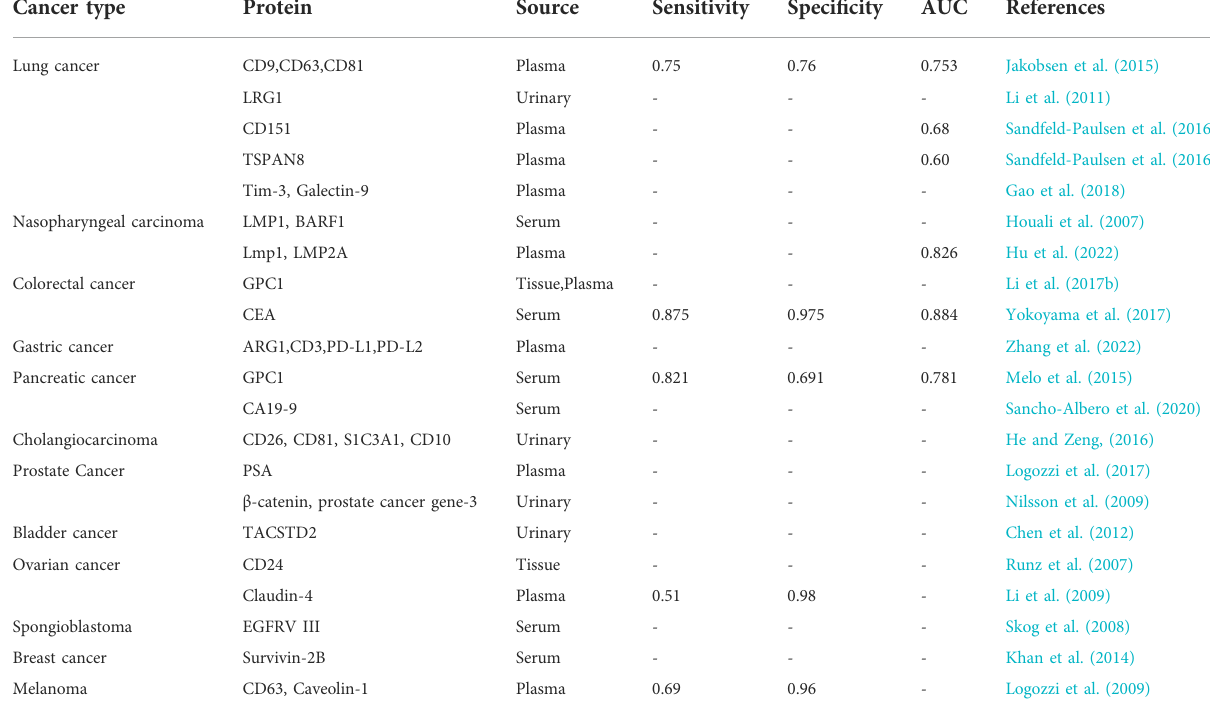
TABLE 1 EVs secreted in different body fl uids and their potential cancer